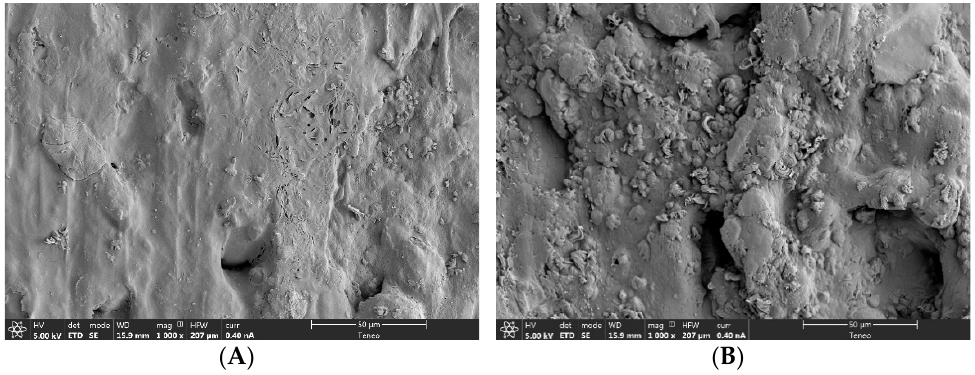
Figure 2. SEM images, magnification 1000 × : ( A ) 40A; ( B ) 40B.